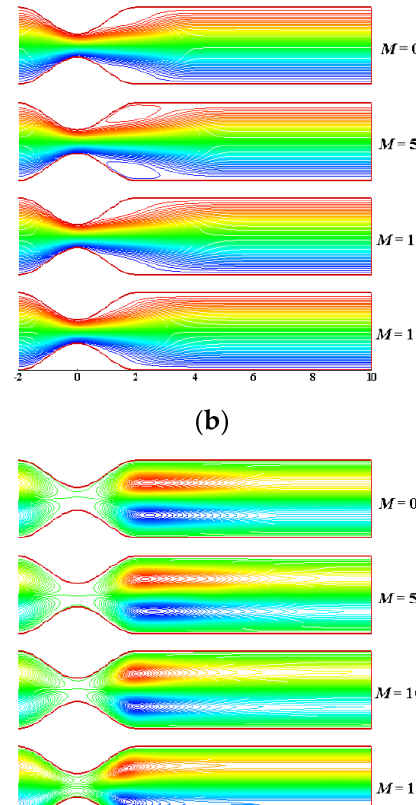
Figure 9. Effects of ( a ) micropolar parameter ( b ) Reynolds number, and ( c ) Hartmann number on micro-rotation velocity profile at t = 0.25 .